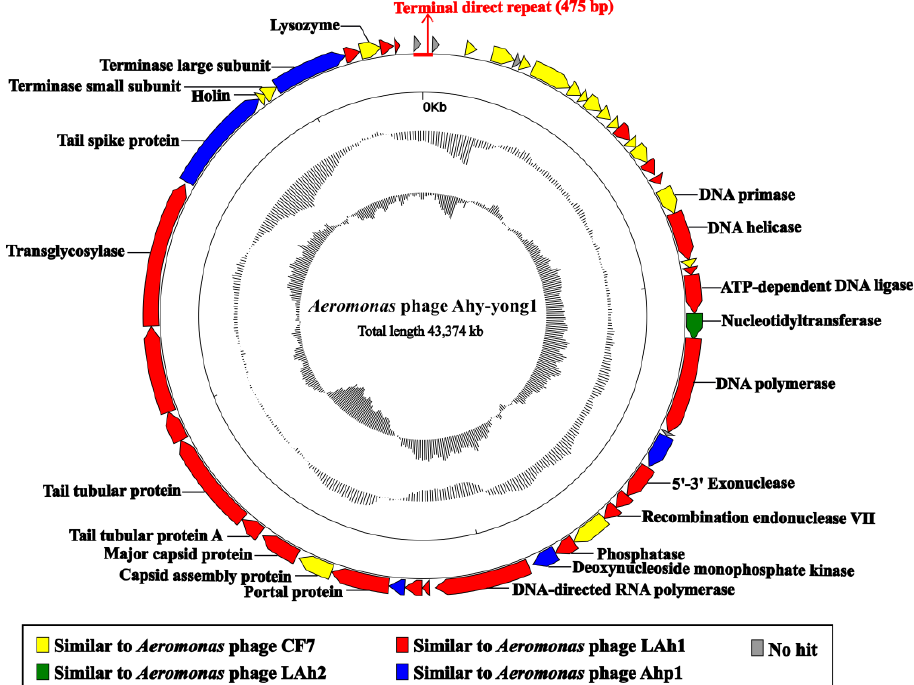
Figure 5. Genomic map of Aeromonas phage Ahy-yong1. From outside to inside, circle 1 shows the 52 predicted ORFs, circle 2 shows the size in pairs (kb), circle 3 displays the GC of the genome, and the innermost circle shows the GC skew plot (G − C)/(G + C). The direction of the arrow indicates the transcription direction of each gene. The color of each gene refers to the most similar phages, yellow stands for the gene similar to the Aeromonas phage and gray for the gene without similarity in the NCBI database.